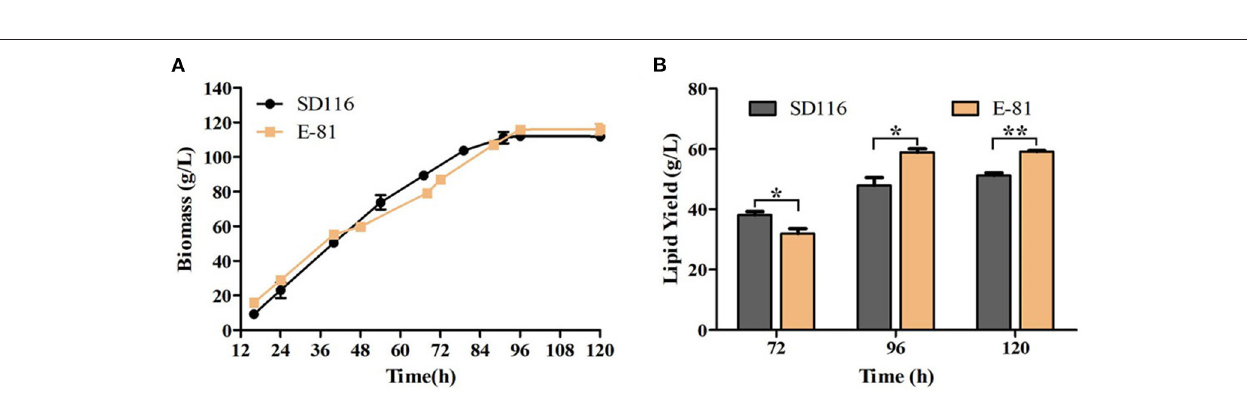
Frontiers in Nutrition |